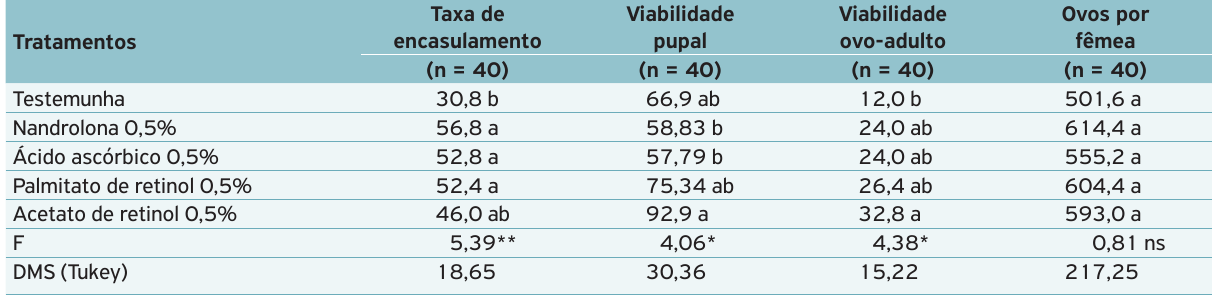
Tabela 4. Taxa de encasulamento (%), viabilidade pupal (%), viabilidade de ovo a adulto (%) e número médio de ovos por fêmea